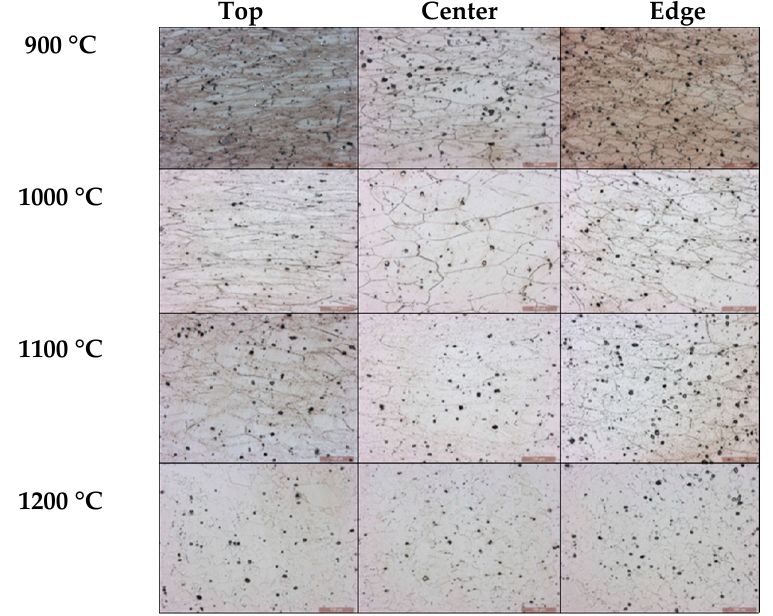
Figure 4. Microstructures of Inconel 625 specimens after the compression test according to the temperature.